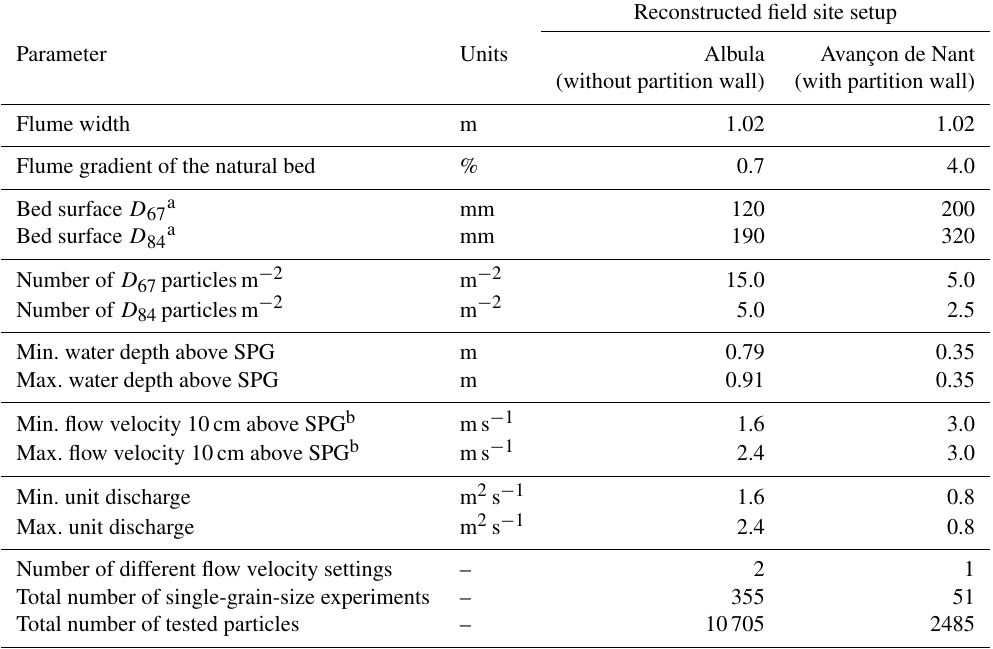
Table 2. Flume and hydraulic characteristics for the reconstruction of the Albula and Avançon de Nant field